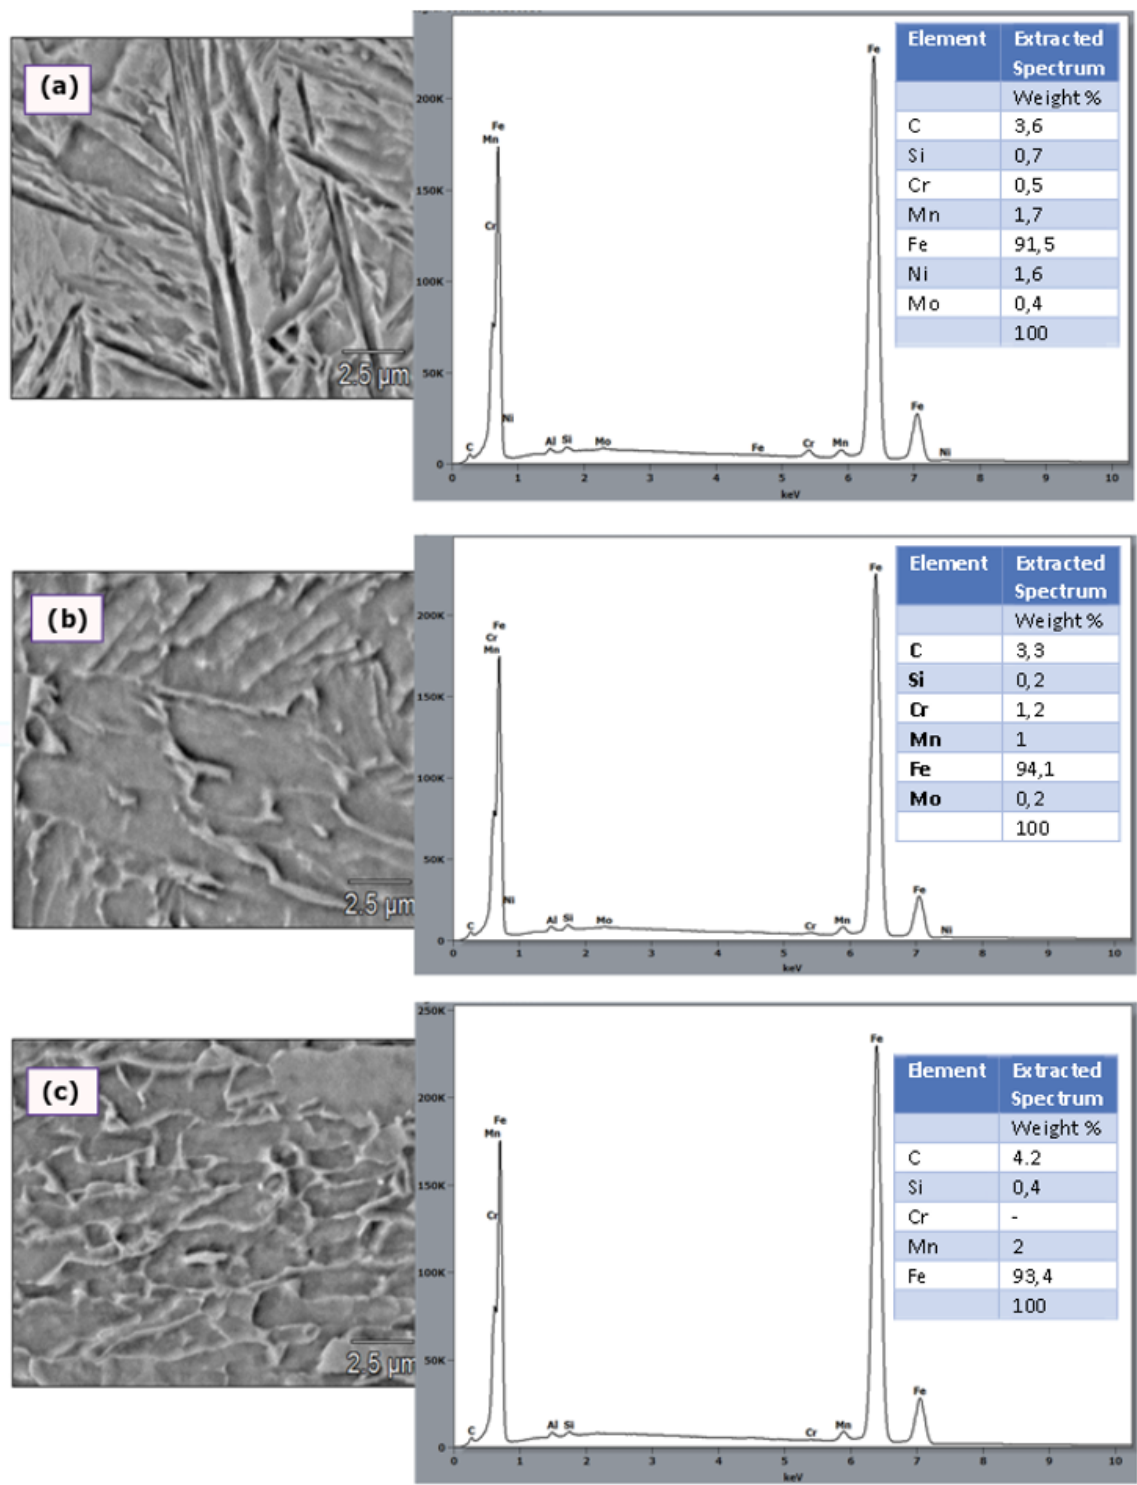
Figure 5: EDS X-ray mapping showing the alloy element composition: (a) WM mapping using overmatched filler wire, (b) CGHAZ of S700MC, (c) CGHAZ of